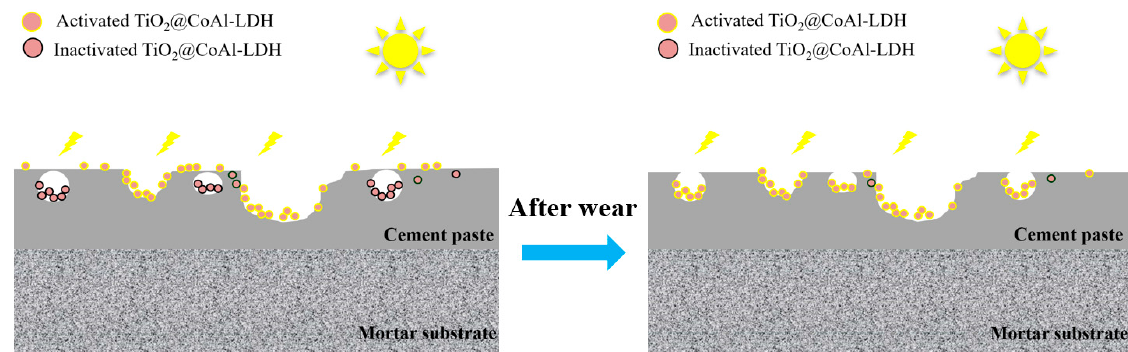
Figure 9. A proposed illustration of the pore structure formation on the surface of mortar prepared by smearing method.